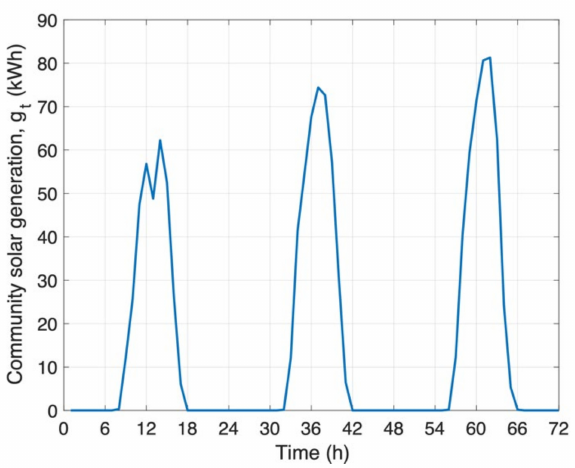
Figure 6. Example of community solar generation over three